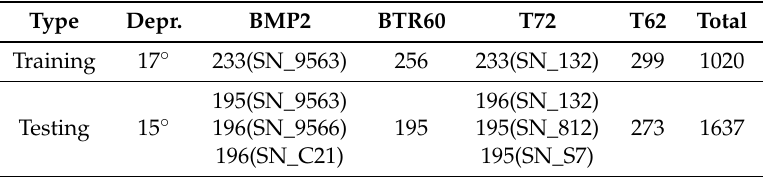
Figure 4. The examples of BMP2, BTR60, T72 and T62 with optical and SAR images. Table 1. The training and testing samples in the experiments.